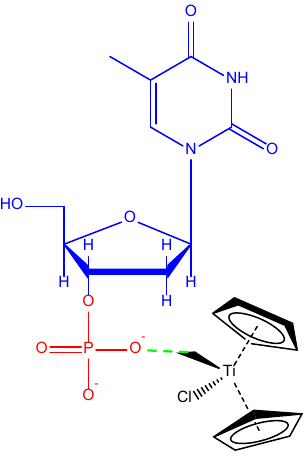
Figure 5. Interaction of the compound TiCp 2 Cl 2 with DNA phosphate groups. Blue: nucleoside, red: